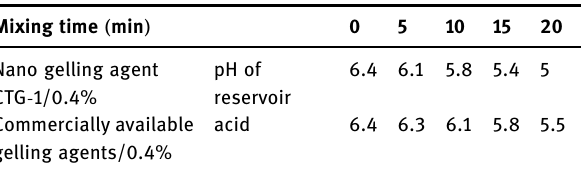
of carbonate rock reservoirs Mixing time ( min